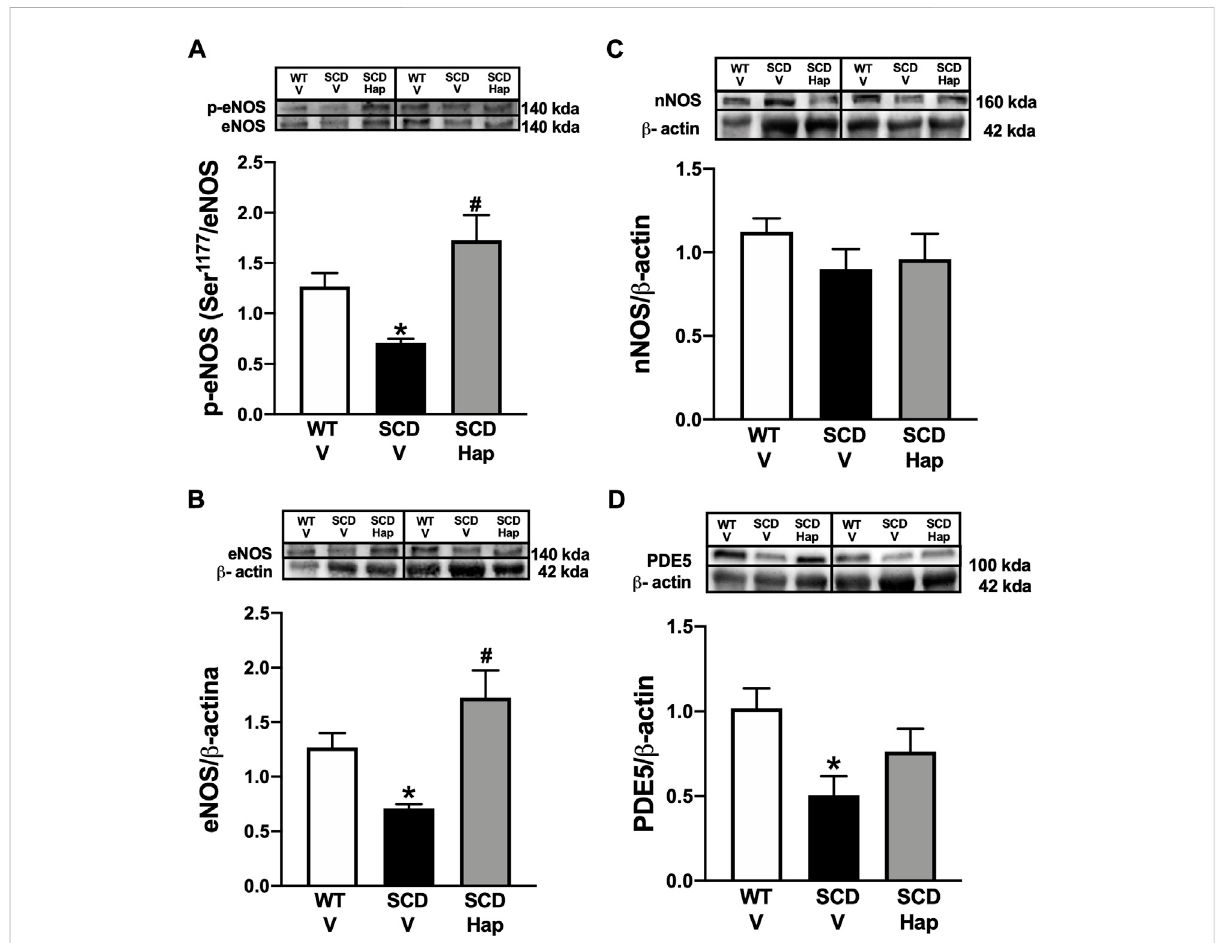
FIGURE 4 Representative images of western blotting (top panels) and protein values (bottom panels) for p-eNOS (Ser-1177; (A) , eNOS (B) , nNOS (C) , and PDE5 (D) in homogenates of penises from WT and SCD mice treated or not with haptoglobin (Hap). Data represent the mean ± S.E.M. for 6 mice in each group. A single band for eNOS, nNOS and PDE5 was normalized to β -actin. A single band for p-eNOS (Ser-1177) was normalized to eNOS. * p < 0.05 vs. WT-Vehicle. # p < 0.05 vs.